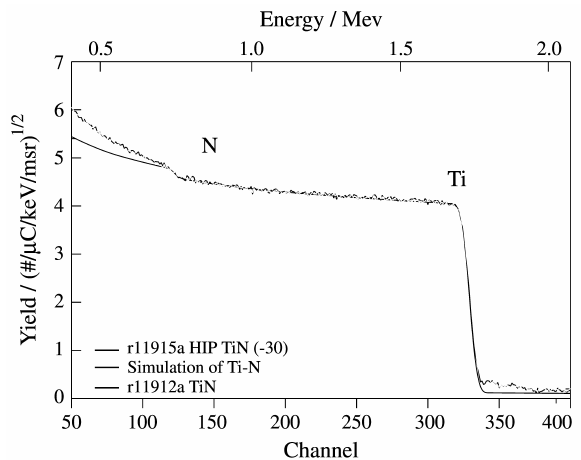
Figure 6. RBS from TiNfilm. The red line wasgenerated by the software HUMP to fit the experimental data. From this fitness the Ti:N ratio was estimated to be 1:1. A He + beam with total accumulated charge of 30 µ C was used. The detector was set at the angle -30°.